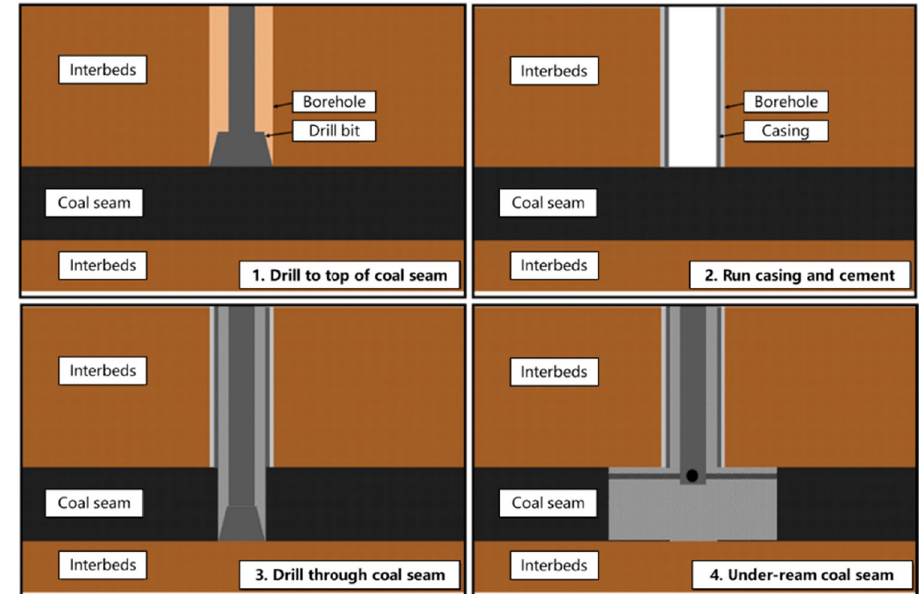
Fig. 27 Schematic of under- ream completion (Caballero